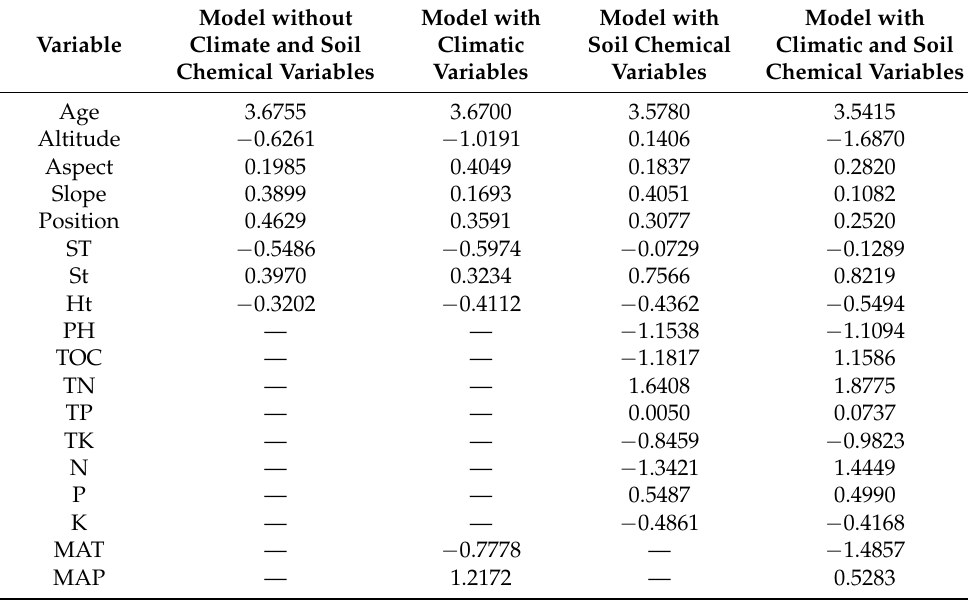
Table A3. Parameter values of the variables of the linear regression